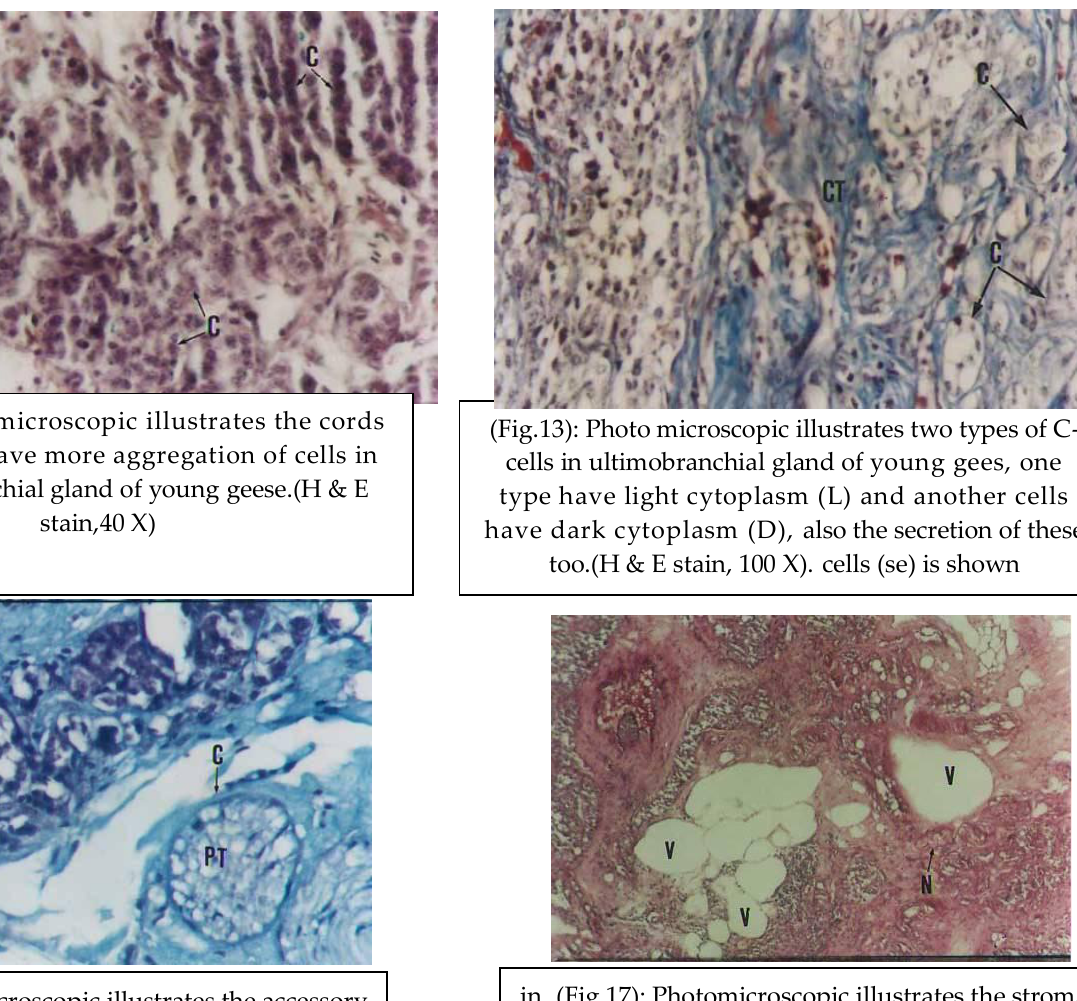
(Fig.16): Photo microscopic illustrates the accessory parathyroid nodule (PT) in ultimobranchial gland of adult geese enclosed by connective tissue capsule(C). (Masson trichrome stain, 40 X).